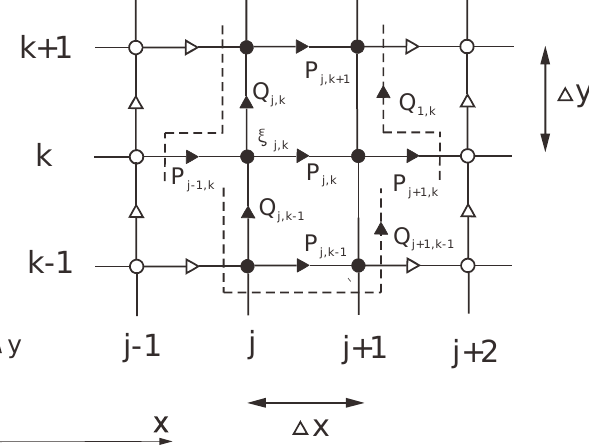
Figure 1. Schematic diagram of the MIKE 21 BW 2D model discrete method.